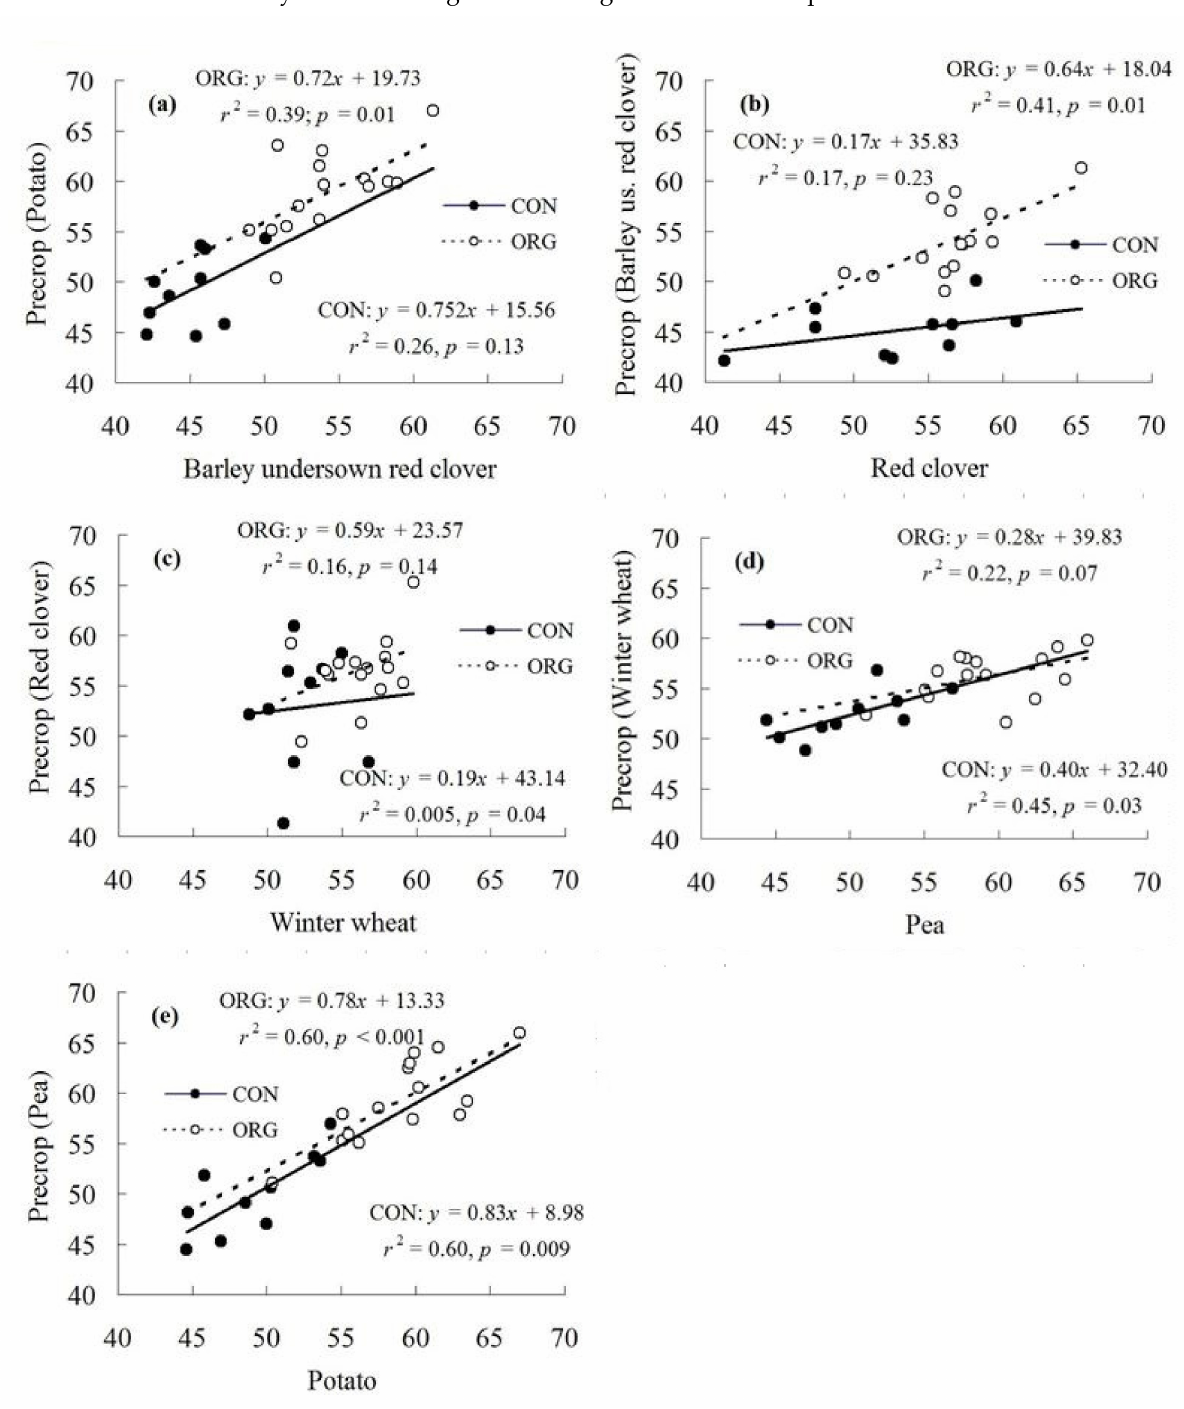
Figure 1. The regression analysis of the soil hydrolytic activity ( µ g fluorescein g − 1 soil dry weight h − 1 ) of main crop and precrop in conventional and organic farming systems. ( a ) Barley undersown with red clover (precrop was potato); ( b ) red clover (precrop was barley undersown with red clover); ( c ) winter wheat (precrop was red clover); ( d ) pea (precrop was winter wheat); ( e ) potato (precrop was